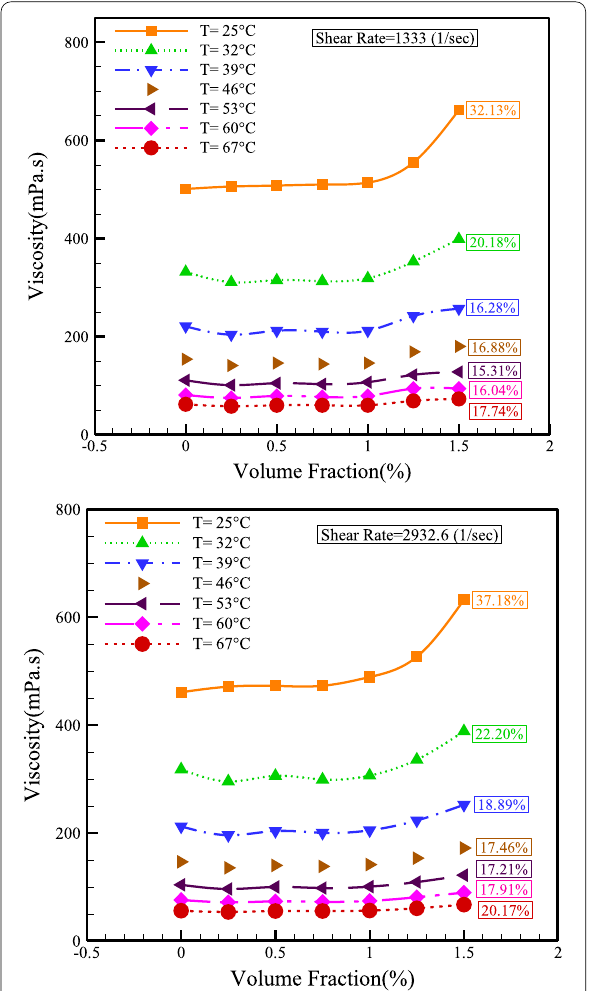
Fig. 10 Changes in viscosity with NPSVF at different SRs